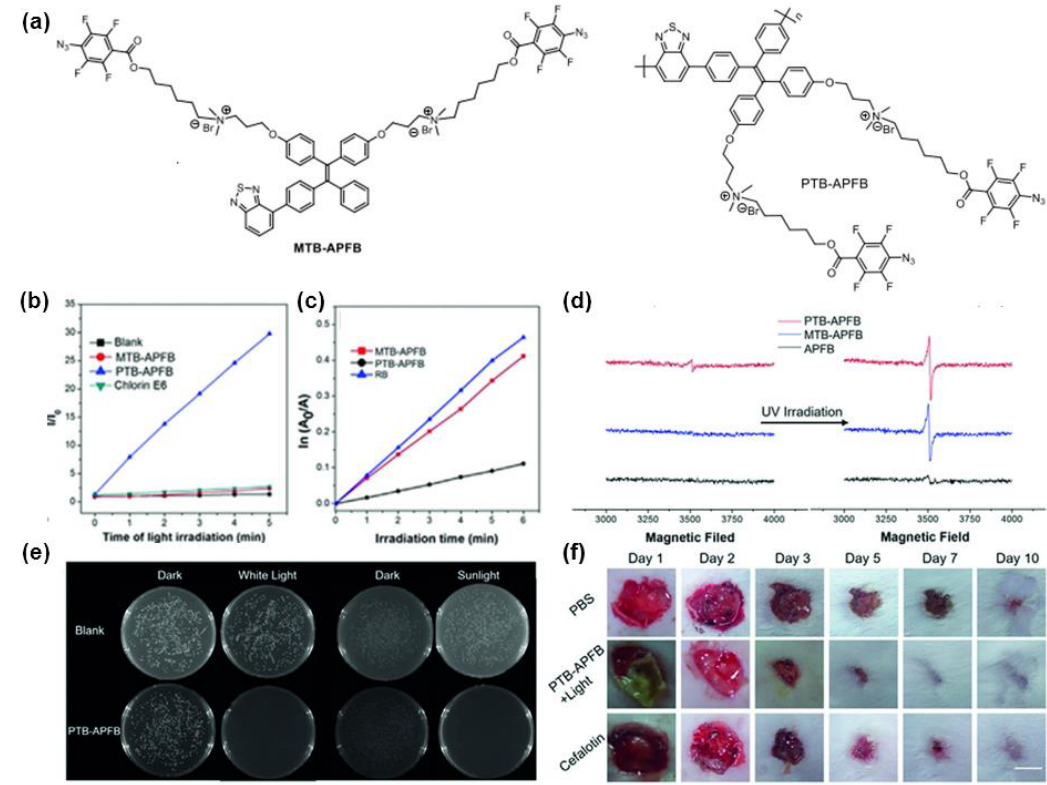
Figure 9. ( a ) The chemical structures of MTB-APFB and PTB-APFB. ( b ) The ROS generation ability of PTB-APFB, MTB-APFB and Ce6 upon exposure to white light for different irradiation times. ( c ) The 1 O 2 generation ability of PTB-APFB, MTB-APFB and RB in PBS buffer under different irradiation times. ( d ) The radical generation ability of PTB-APFB and MTB-APFB after UV irradiation. ( e ) Photographs of biocidal activity of PTB-APFB treated S. aureus under white light, sunlight and dark conditions. ( f ) Photographs of the mice skin infected with S. aureus during treatment with different formulations. Reprinted with permission from Ref. [62]. 2020, Wiley-VCH.